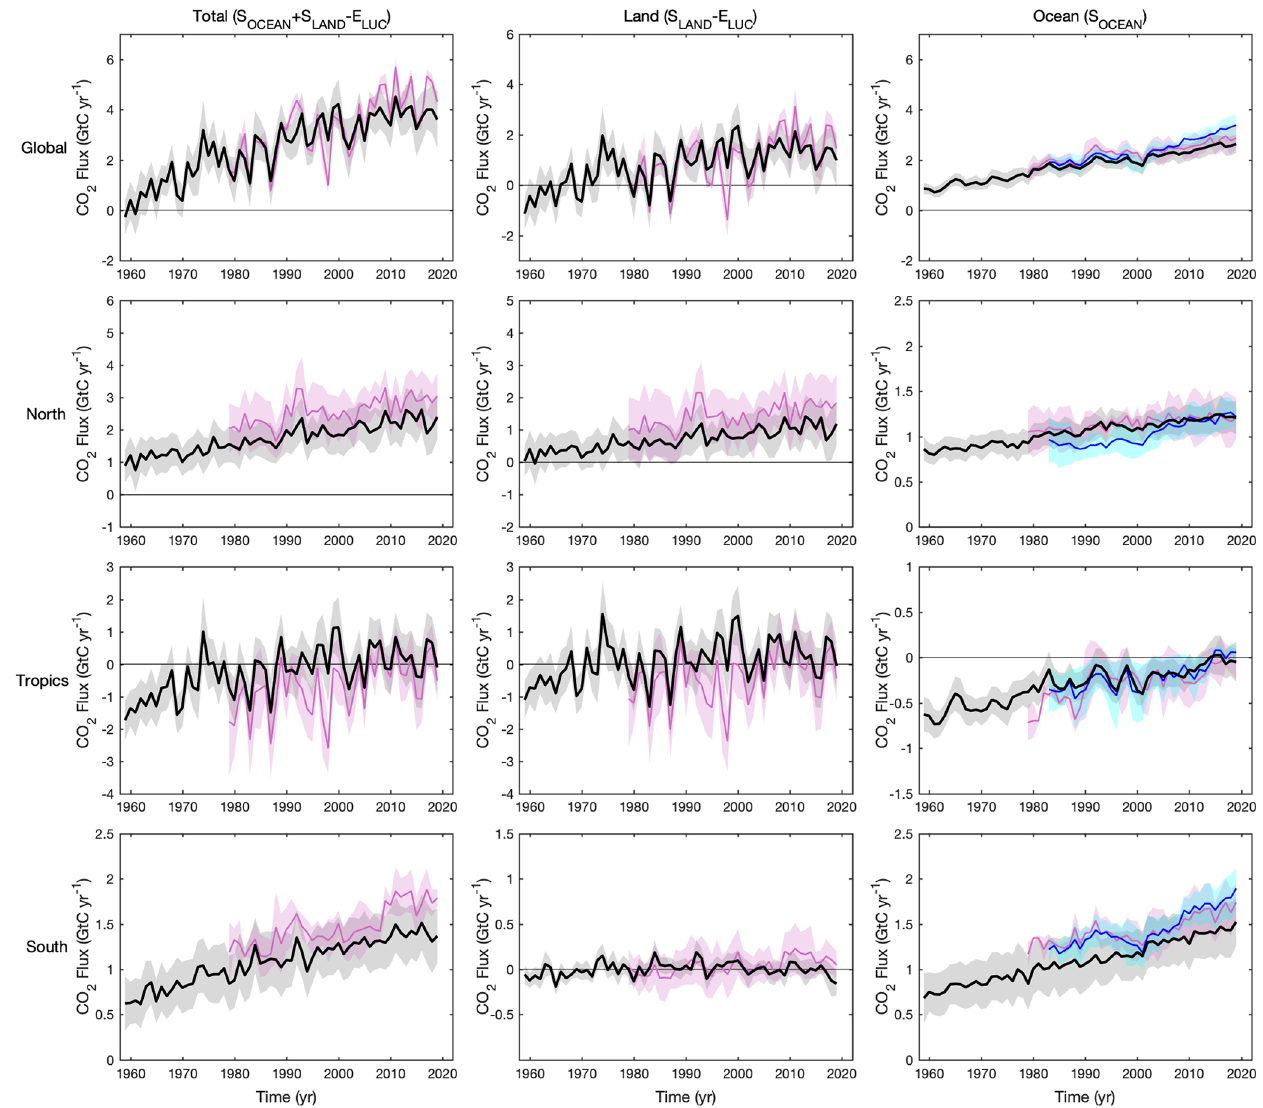
Figure 8. CO 2 fluxes between the atmosphere and the surface, S OCEAN and ( S LAND – E LUC ) by latitude bands for the (top row) globe, (second row) north (north of 30 ◦ N), (third row) tropics (30 ◦ S–30 ◦ N), and (bottom) south (south of 30 ◦ S), and over (left) total ( S OCEAN + S LAND − E LUC ), (middle) land only ( S LAND − E LUC ), and (right) ocean only ( S OCEAN ). Positive values indicate a flux from the atmosphere to the land and/or ocean. Mean estimates from the combination of the process models for the land and oceans are shown (black line) with ± 1 σ of the model ensemble (grey shading). For total uncertainty, the land and ocean uncertainties are summed in quadrature. Mean estimates from the atmospheric inversions are shown (pink lines) with their ± 1 σ spread (pink shading). Mean estimates from the p CO 2 -based flux products are shown for the ocean domain (dark blue lines) with their ± 1 σ spread (light blue shading). The global S OCEAN (upper right) and the sum of S OCEAN in all three regions represents the anthropogenic atmosphere-to-ocean flux based on the assumption that the pre-industrial ocean sink was 0GtCyr − 1 when riverine fluxes are not considered. This assumption does not hold on the regional level, where pre-industrial fluxes can be significantly different from zero. Hence, the regional panels for S OCEAN represent a combination of natural and anthropogenic fluxes. Bias-correction and area-weighting were only applied to global S OCEAN ; hence the sum of the regions is slightly different from the global estimate ( < 0.08GtCyr − 1